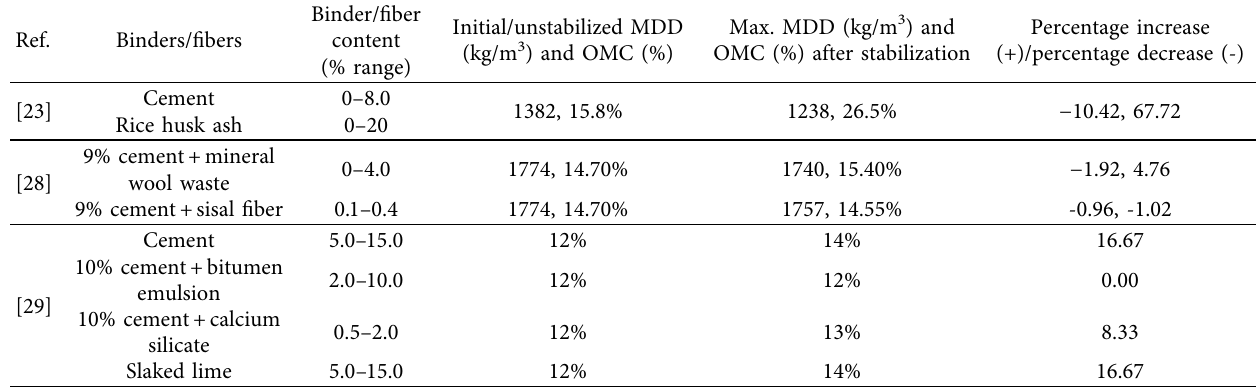
Table 9: MDD and OMC values of unfired admixed soil blocks as reported in the reviewed articles. Ref.